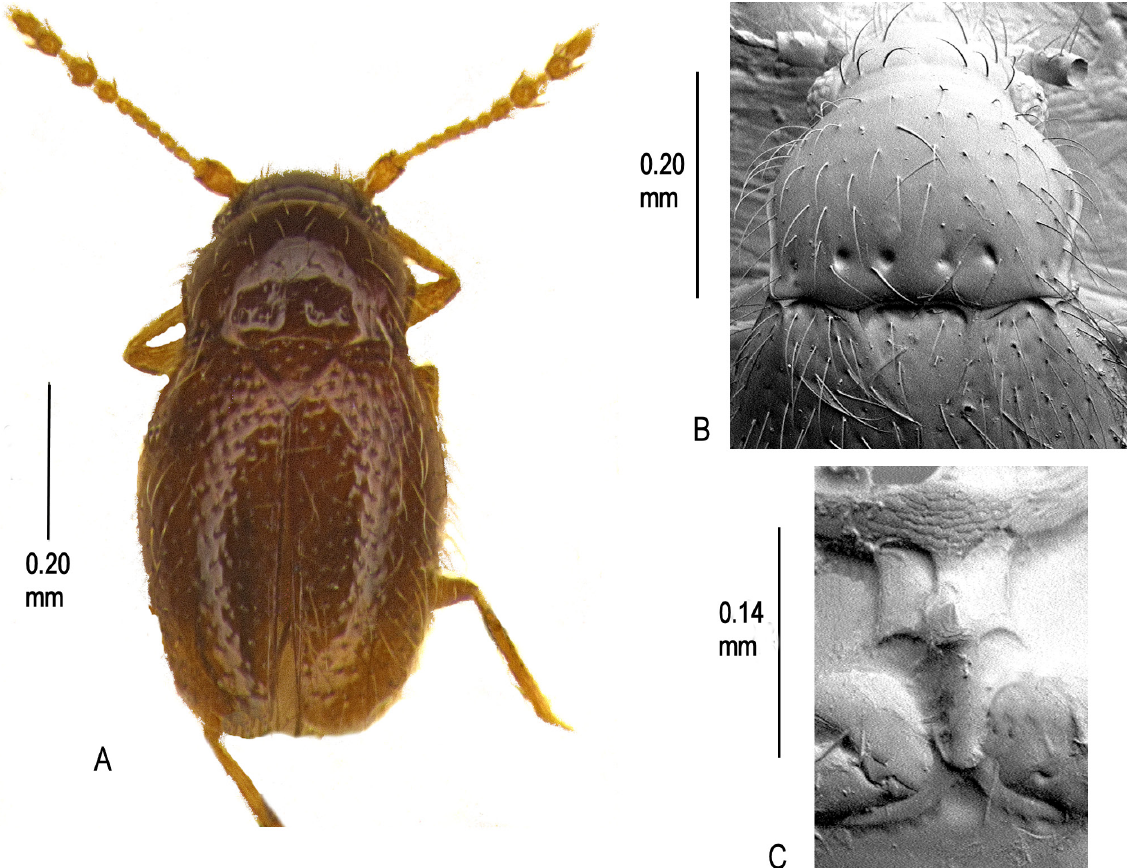
Fig. 33 . Cissidium matthewsi Johnson, 2007. A . Habitus. B . Pronotum, × 430. C . Mesoventrite showing median process of collar, mid-keel and keel,